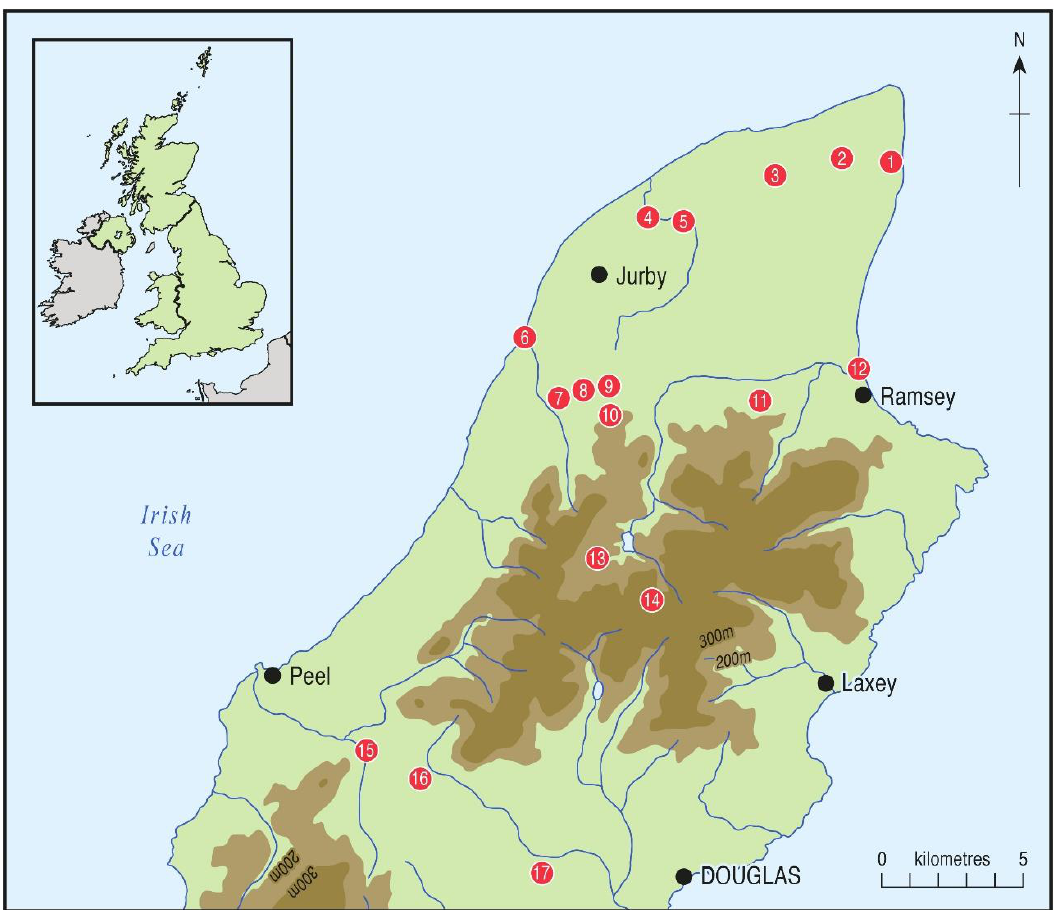
Figure 1. Location of the Isle of Man in the Irish Sea between Britain and Ireland and the location of the following sites mentioned in the text: 1. Port Cranstal 2. Lough Cranstal 3. Curragh y Cowle 4.